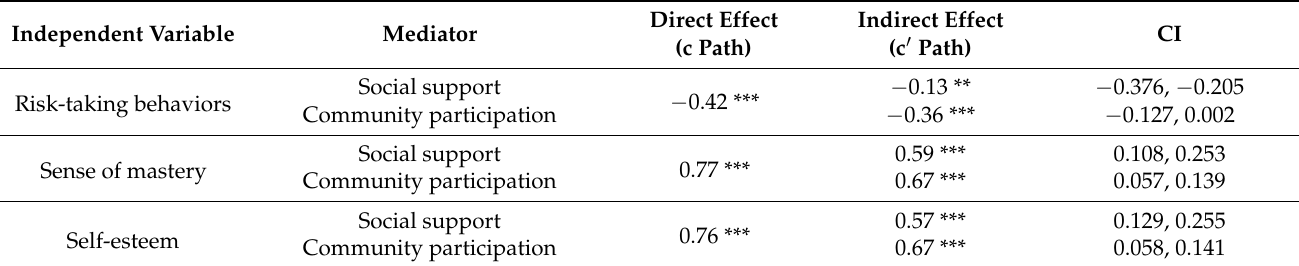
Table 3. Standardized coefficients of the direct and indirect connections of the independent variables with life satisfaction (5000 bootstraps) and the effects of